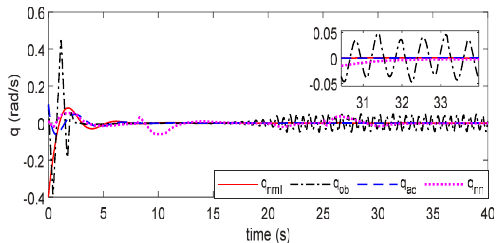
Figure 7. Tracking effects of pitch rate q .